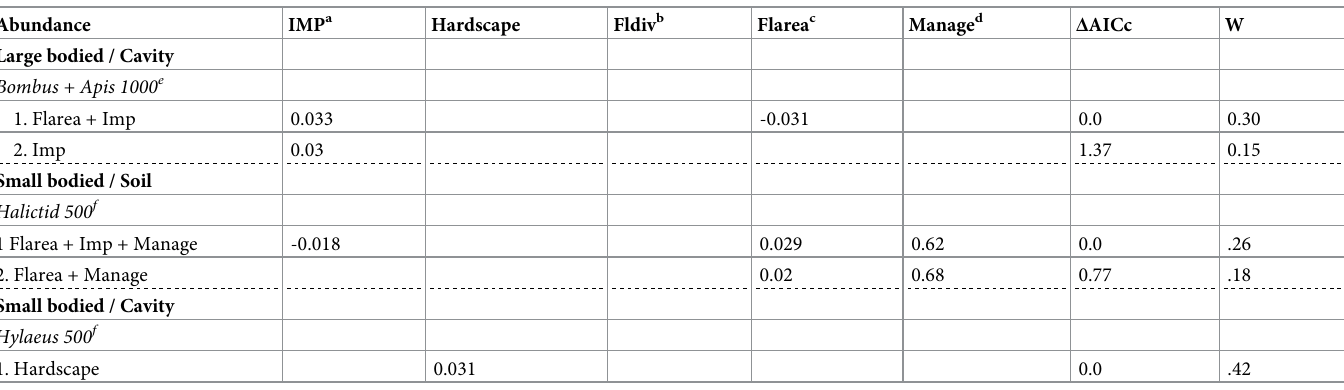
Table 1. Model selection results for bee abundance by body size and nesting habit. Abundance